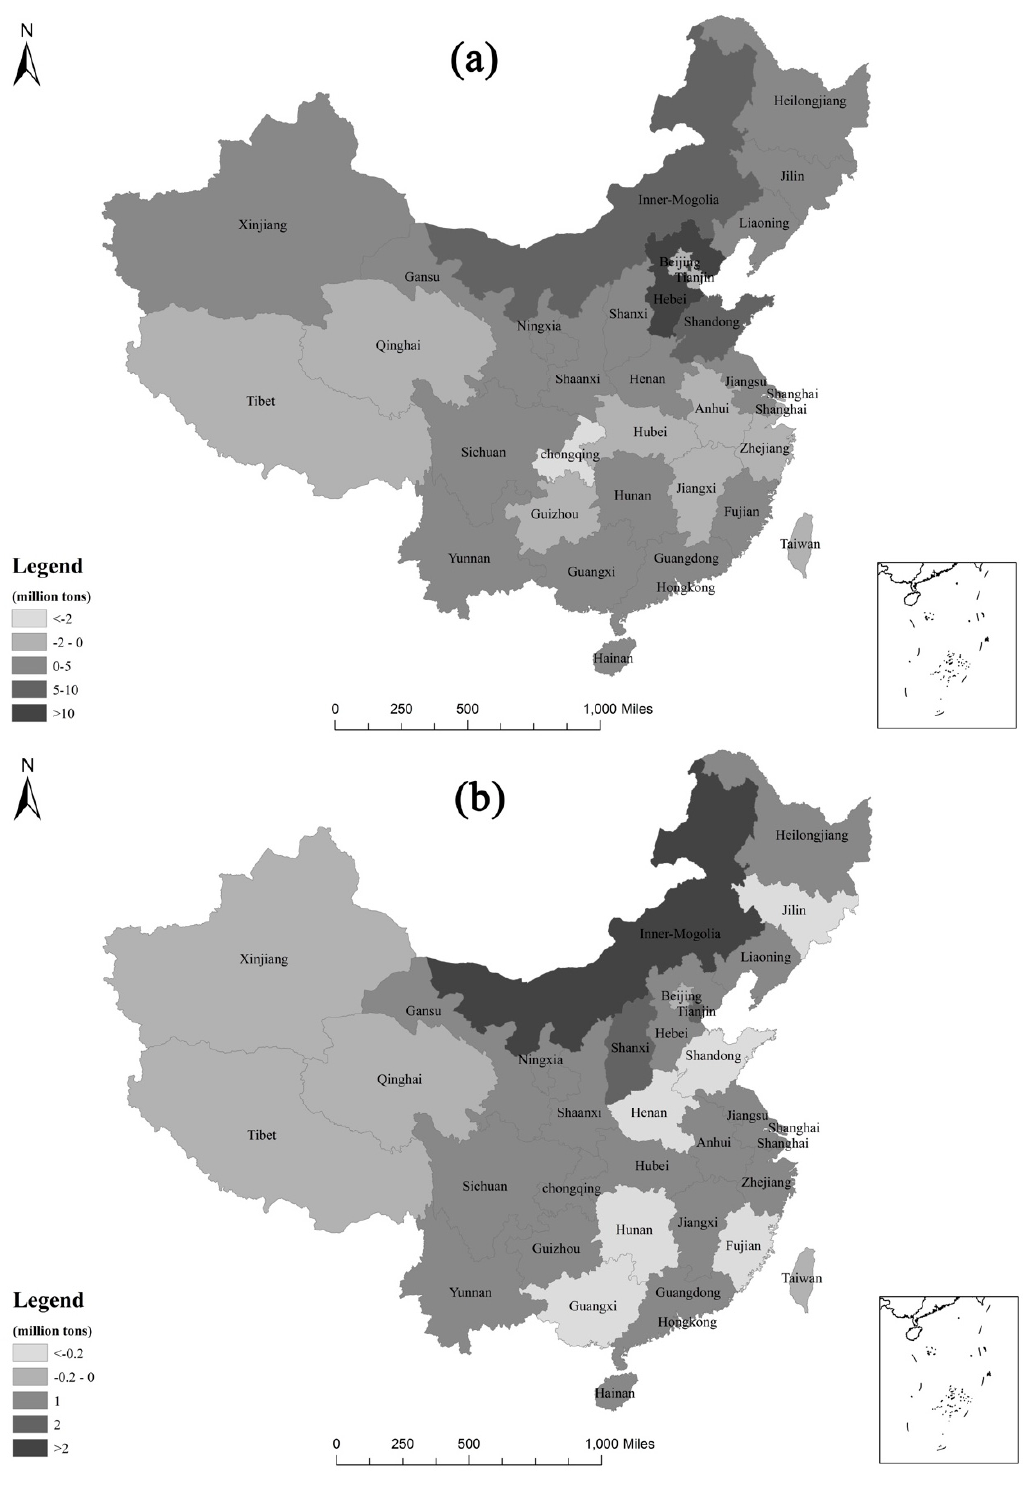
Figure 4. Net embodied carbon flowed in Beijing during the periods of ( a ) 2002–2007 and ( b ) 2007–2010 (million tons).